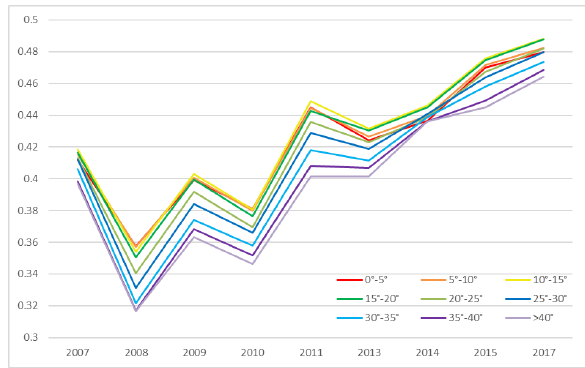
Figure 8. Broken-line graph showing EVI changes from 2007 to 2017 in different slope zones.